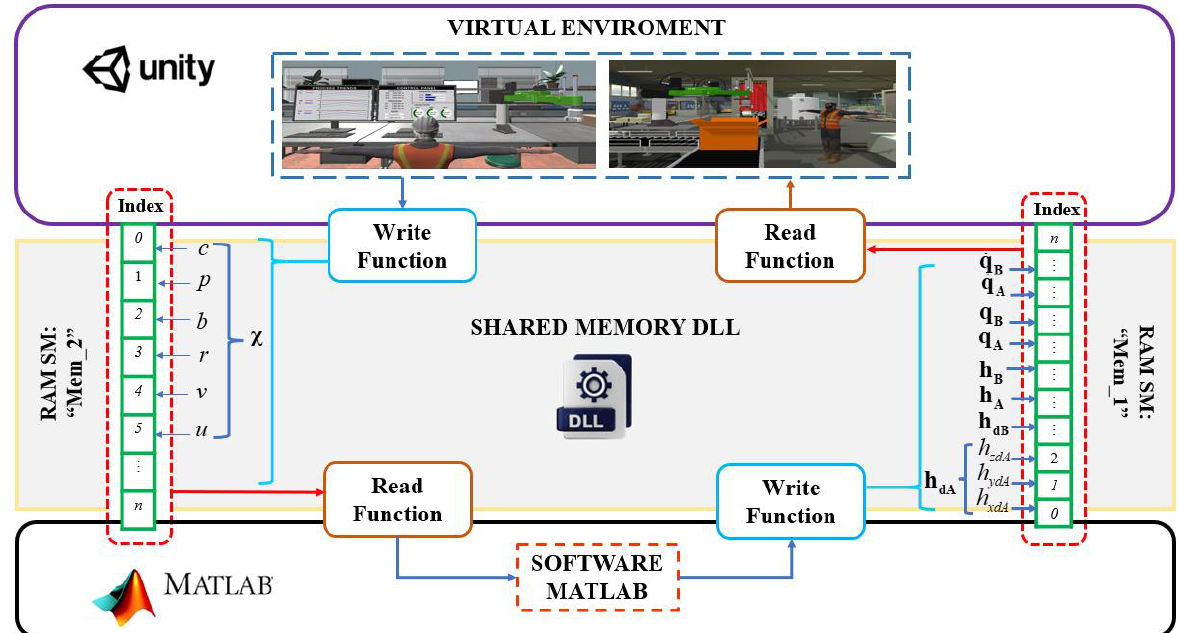
Figure 5. Information exchange structure between MatLab and Unity3D through shared memories.